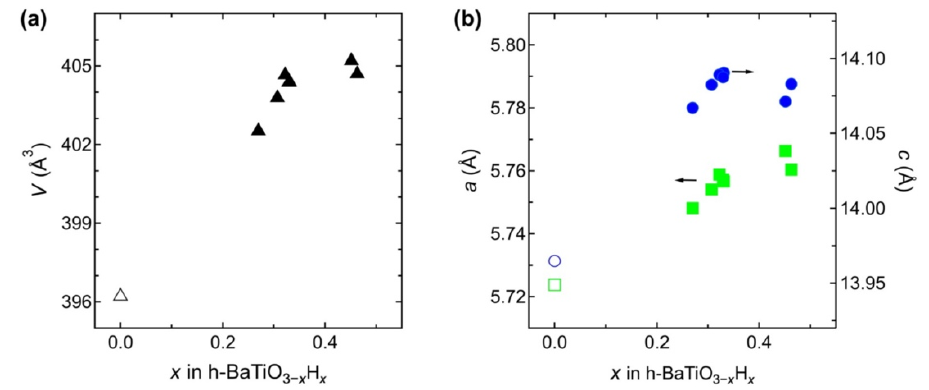
Figure 8. Cell parameters of ( a ) V , ( b ) a , and c as a function of x in 6H-BaTiO 3 − x H x (see Table S4-8). The errors are within the size of the symbols. The values for x = 0 (open symbols) are taken after Akimoto [28].